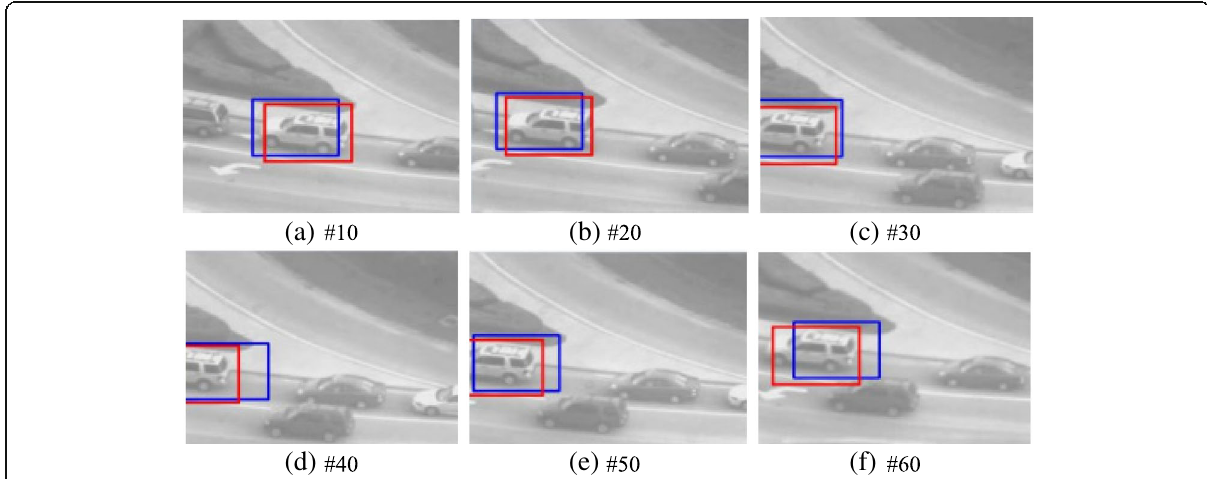
Fig. 12 Tracking results of the partial car video. a , b , c , d , e and f represent 10th frame, 20th frame, 30th frame, 40th frame, 50th frame and 60th frame, respectively